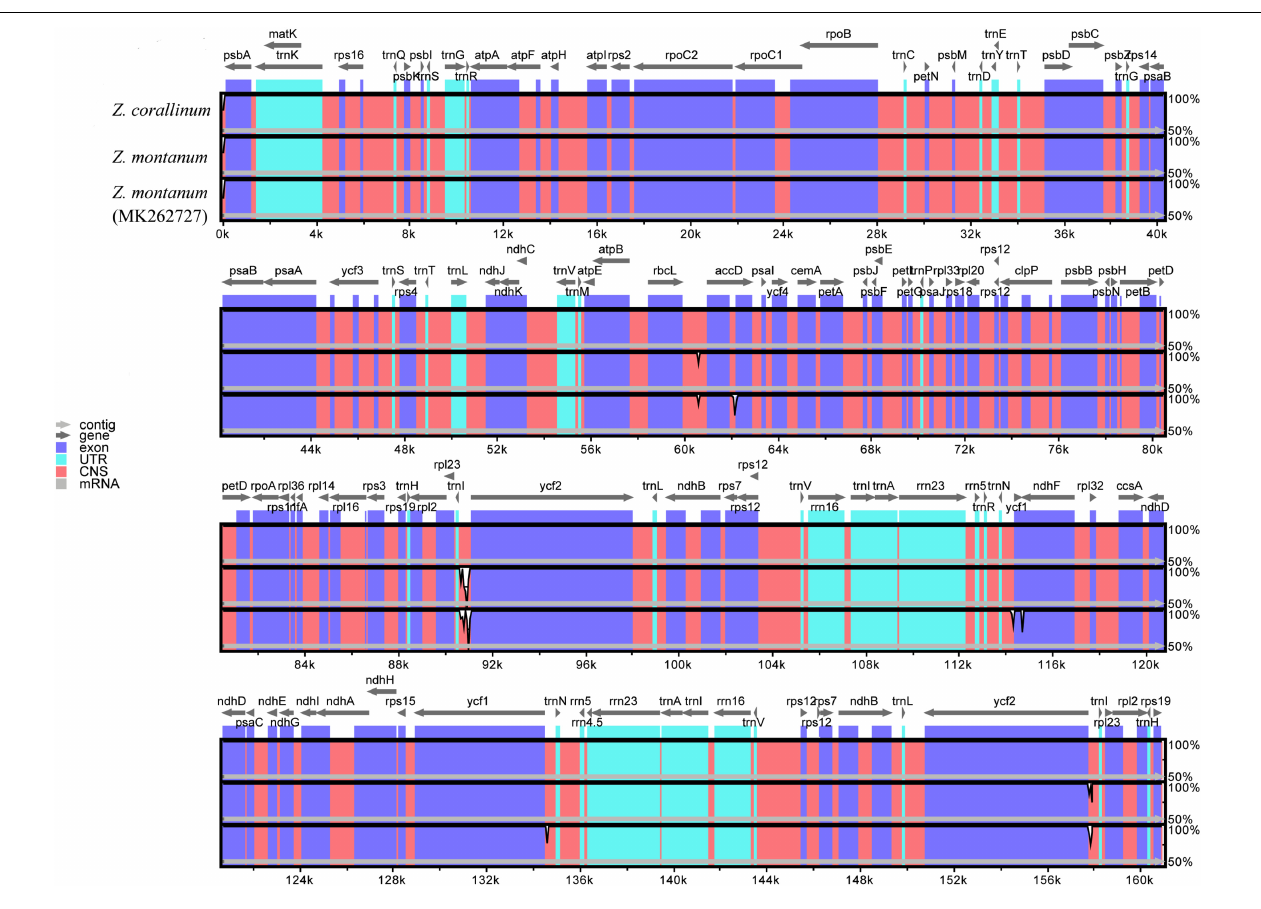
FIGURE 2 | Sequence alignment of three Zingiber chloroplast sequences with Z. corallinum as reference by using in mVISTA. The Y-scale represents the percentage of identity ranging from 50 to